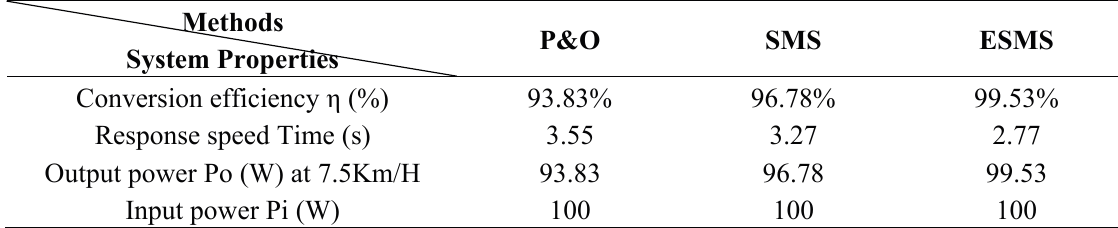
Figure 10. Output power of the three control modes. Table 1. Characteristics of the three control